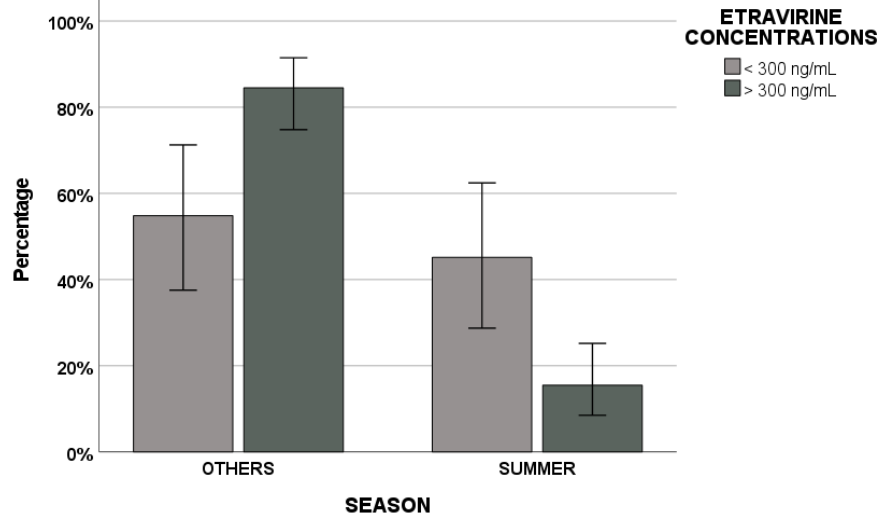
Figure 4. Etravirine efficacy concentration cut-off value of 300 ng/mL in summer vs. other seasons. No difference in ARV concentrations was suggested for monthly evaluation or